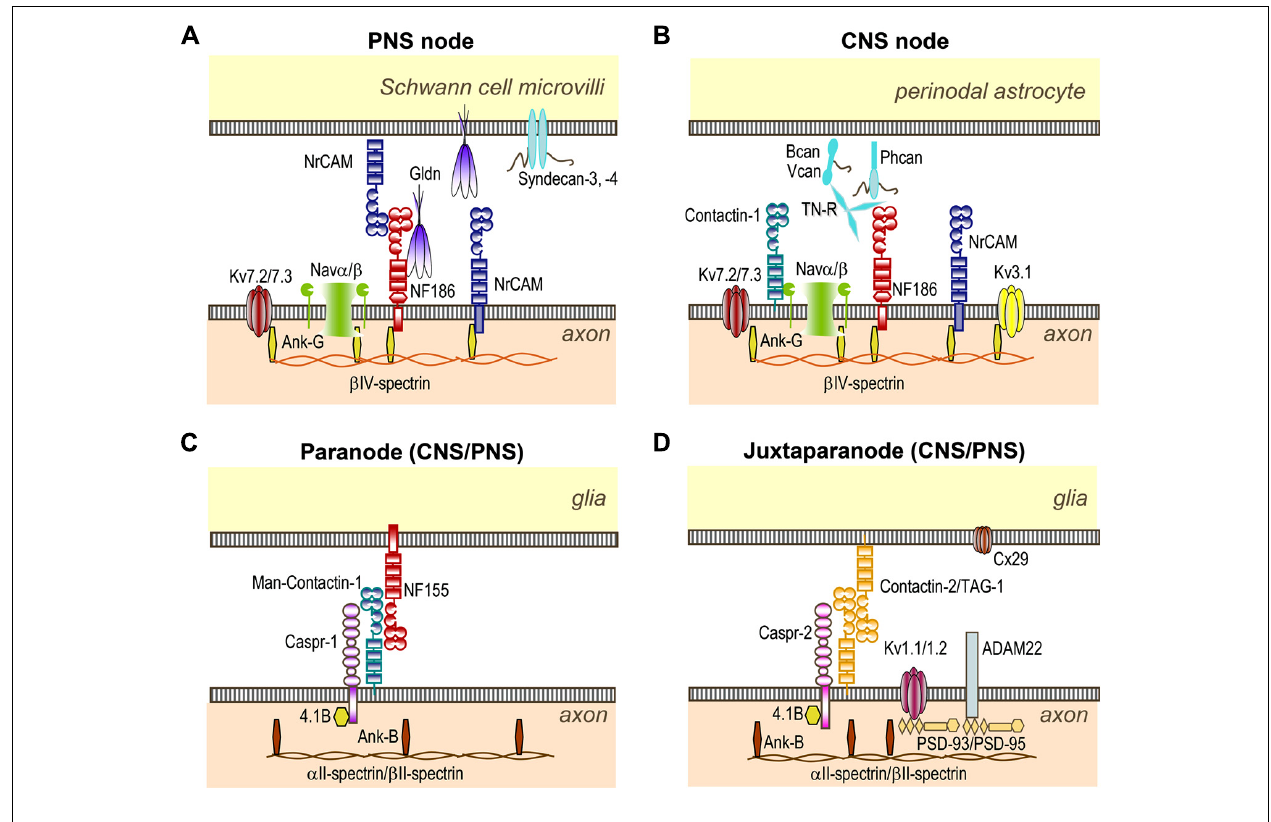
FIGURE 1 | Organization of CNS and PNS nodes of Ranvier. (A) At PNS nodes, NF186 binds Gliomedin (Gldn) and NrCAM which are secreted by Schwann cells in the nodal gap lumen.The cytoplasmic region of axonal NF186 and NrCAM bind ankyrin-G, which anchors the nodal complex to β IV-spectrin and to the actin cytoskeleton. Ankyrin-G enables the clustering of Nav and Kv7.2/7.3 channels at nodes. (B) In the CNS,Tenascin-R (TN-R), Brevican (Bcan),Versican (Vcan), and Phosphacan (Phcan) are enriched in the extracellular matrix surrounding the nodes, and stabilize the nodal complex.